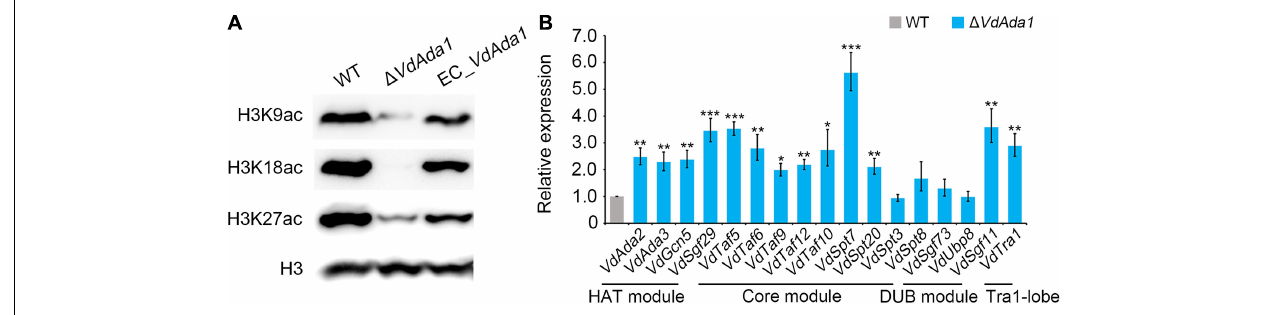
FIGURE 5 | Influence of VdAda1 on histone acetylation in Verticillium dahliae . (A) Different acetylation of histone 3 (H3) were detected in wild type, (cid:49) VdAda1 , and EC_ VdAda1 strains, using anti-H3K9ac, -H3K18ac, -H3K27ac antibodies. Hybridization with an anti-H3 C-terminus antibody served as a loading control. The molecular weight of the tested proteins was 17 kDa. (B) RT-qPCR was performed to detect the change of expression levels of all the subunits of the SAGA complex in (cid:49) VdAda1 strain compared with wild type strain. Error bars represent the standard deviation calculated from three replicate experiments, and the asterisks show significant differences (*** P < 0.001; ** P < 0.01; * P < 0.05) in expression compared with the wild type using one-way analysis of variance (ANOVA).